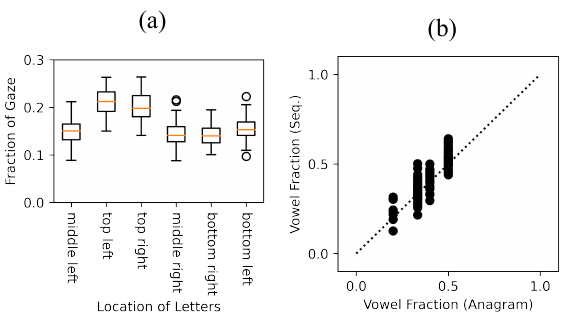
Figure 3. Single-letter gaze patterns. (a) Fraction of gaze time across six letter positions (b) Correlation between the fraction of vowels in presented anagrams and the fraction of vowels in par- ticipant letter sequences (N=29).